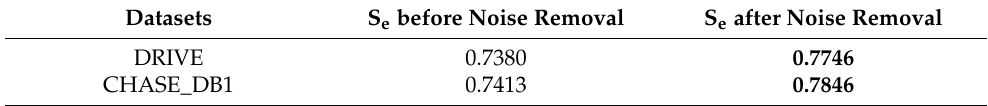
Table 7. Analysis of S e performance indicator by removing noise.